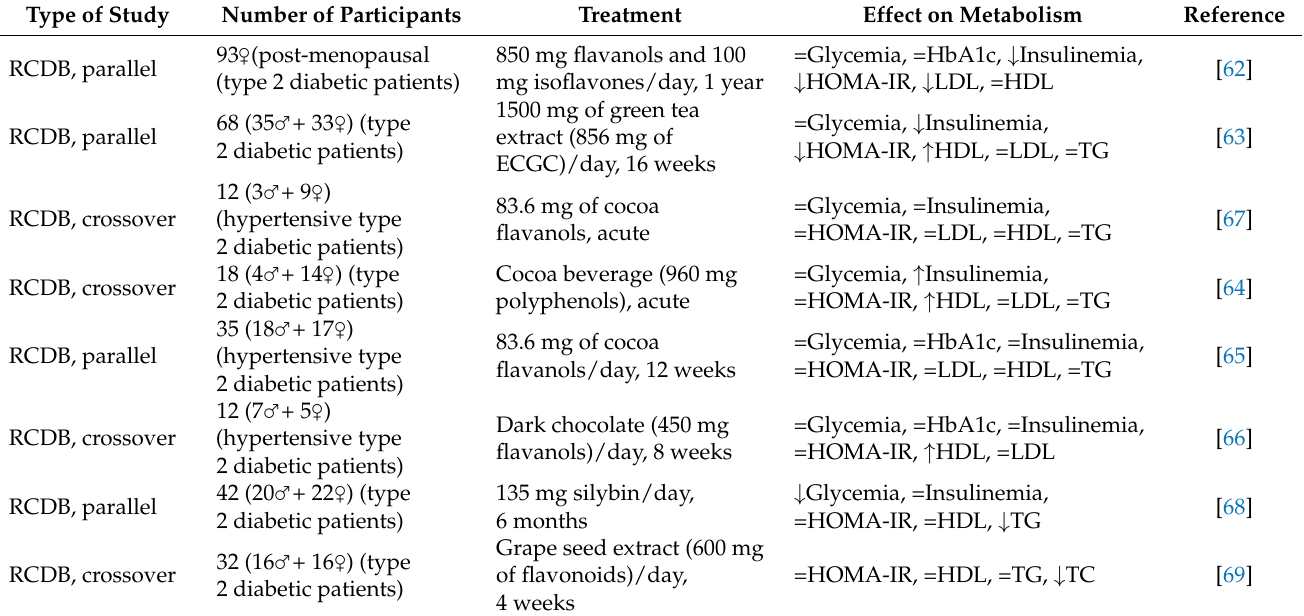
Table 3. Human interventional trials of the effects of flavonoid and flavonoid-rich food intake on insulin resistance in diabetes a